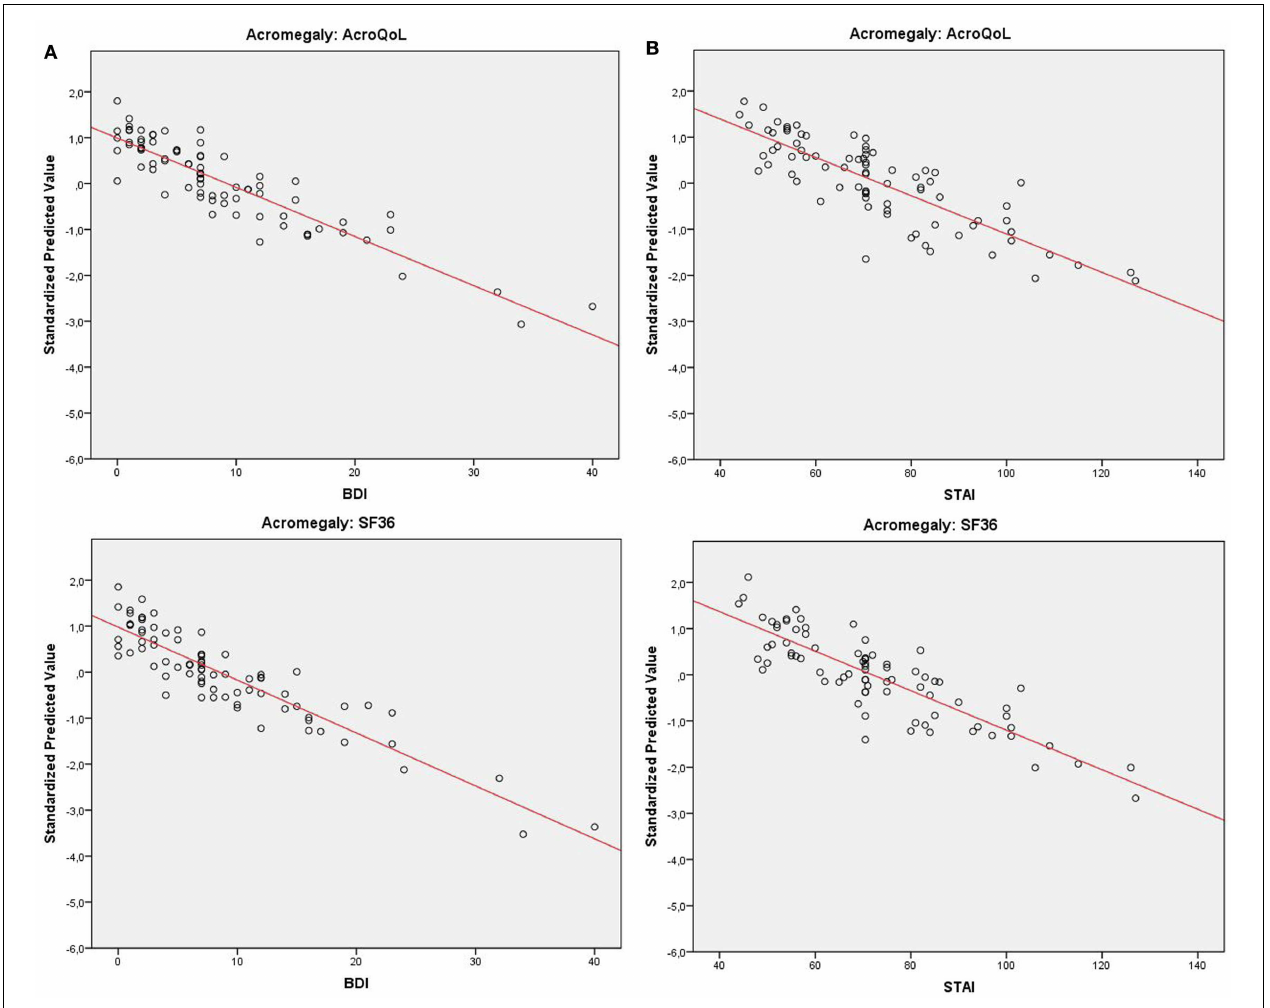
FIGURE 2 | (A) Distribution of QoL in acromegaly (standardized predicted values) relative to depressive symptoms with fitted trend-line. (B) Distribution of QoL in acromegaly (standardized predicted values) relative to anxiety with fitted trend-line.